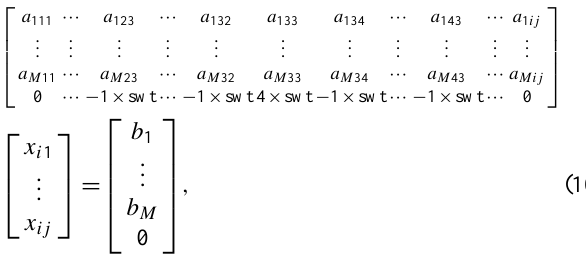
Fig. 4. The tsunami source profiles. (a) Fictitious tsunami source. (b) by Least square inversion only. (c) with smoothing constraint. (d) with smoothing constraint and GSM. The white line in (a) shows the cross-section used in Fig. 5.